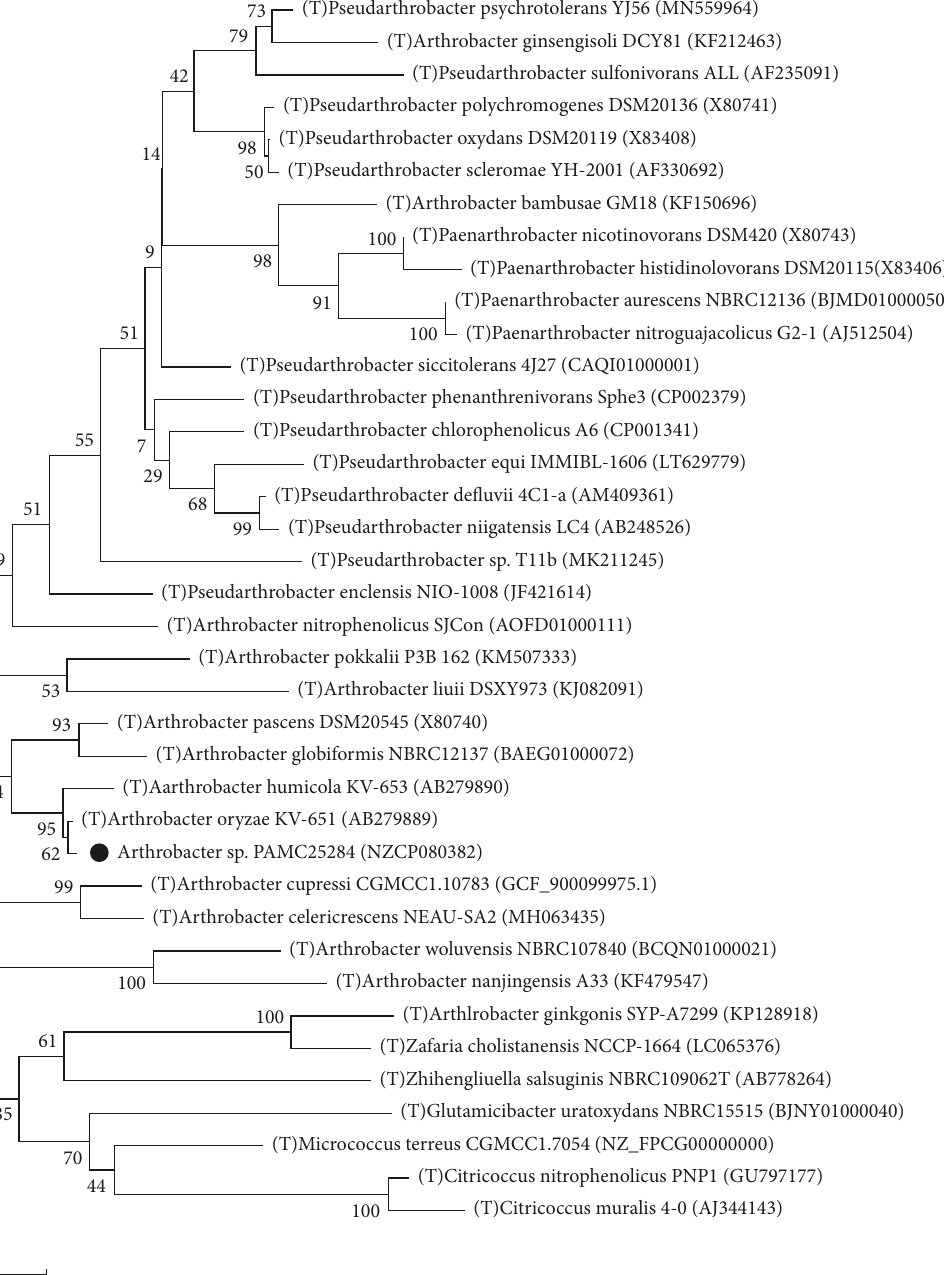
0.005 substitutions per nucleotide position. Accession (cid:31)